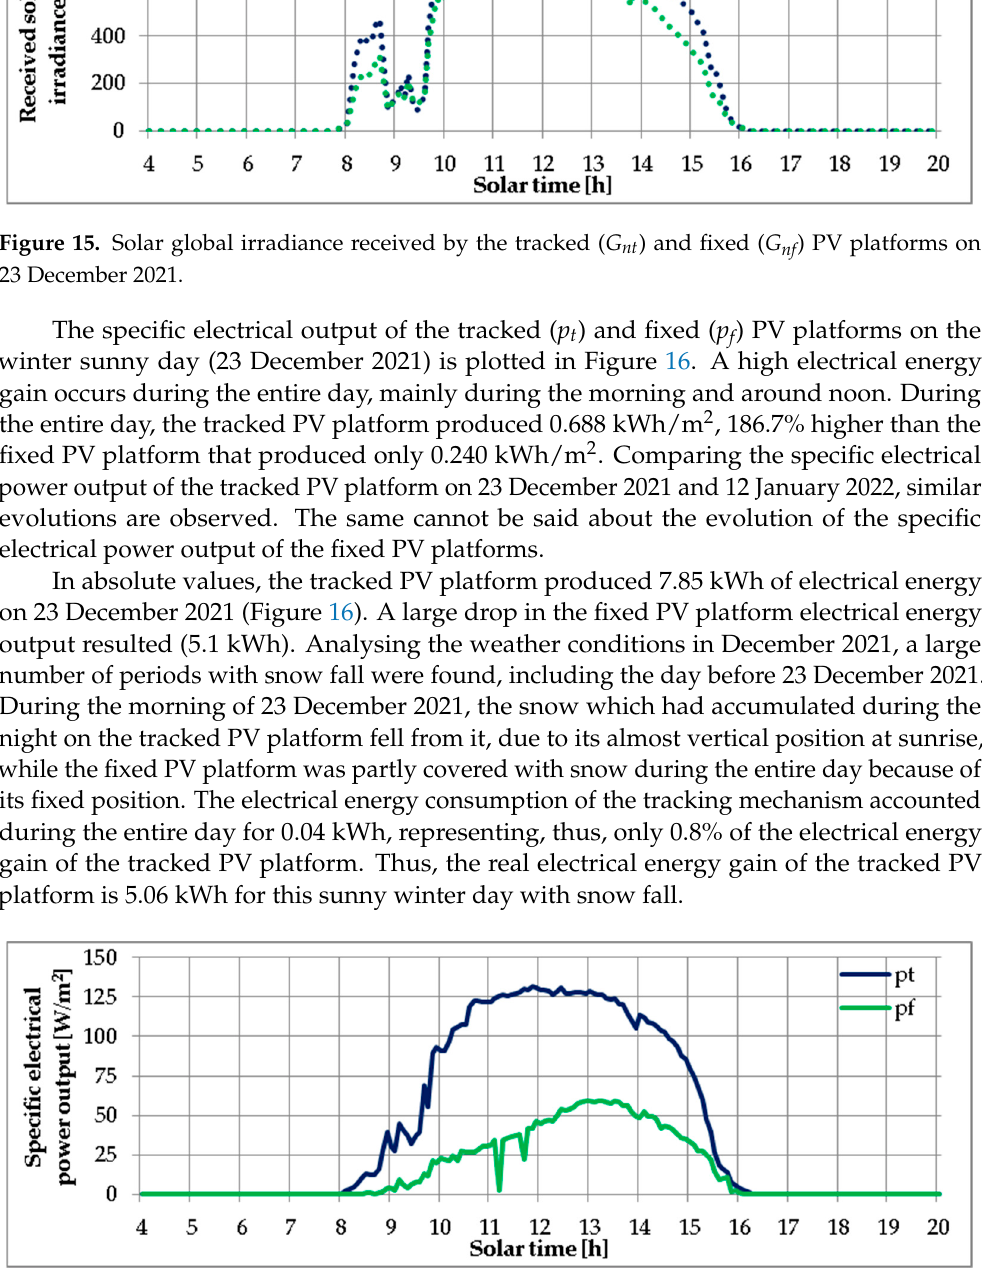
Figure 16. Specific electrical output of the tracked ( p t ) and fixed ( p f ) PV platforms on December 23, 2021.